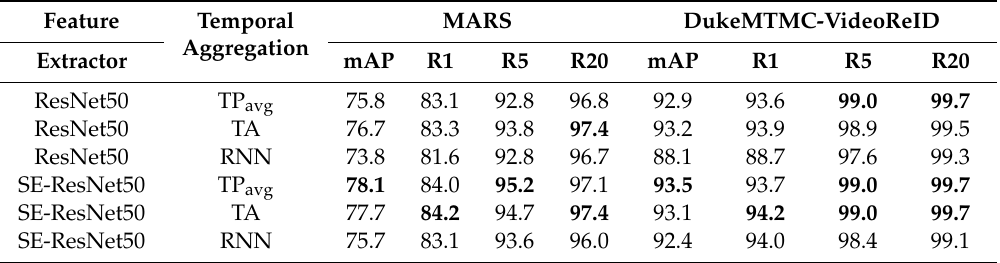
network, respectively. The best results are shown in